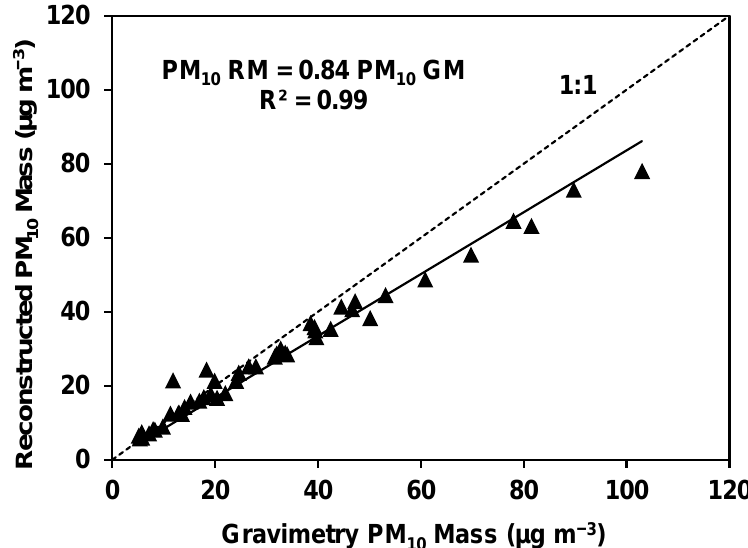
Figure 4. Correlation between water-soluble cations and anions.